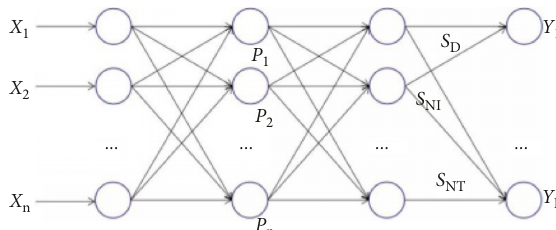
Figure 2: Generalized regression neural network structure diagram.